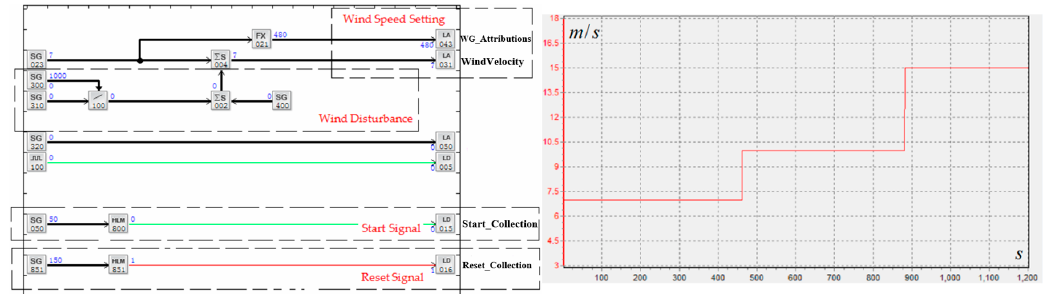
Figure 10. ( a ) The logical configuration of wind speed setting; ( b ) The tendency chart for wind speed modification process. modification